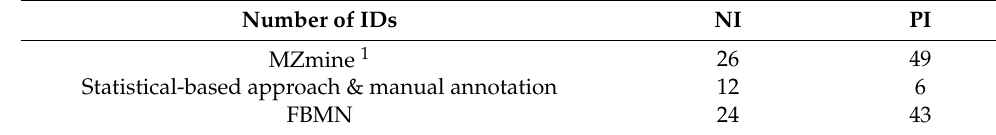
Table 1. Number of IDs annotated by Feature-Based Molecular Networking (FBMN) of NI and PI datasets, including the developed “Nutri-Metabolomics” mass spectral libraries, in comparison with the annotation performed with (i) MZmine Library Search using GNPS compatible mass spectral libraries (ALL_GNPS, https://gnps-external.ucsd.edu/gnpslibrary) (accessed on 5 September 2022) and with (ii) the statistical-based approach followed by manual annotation, reported in Section S5 of the Supplementary